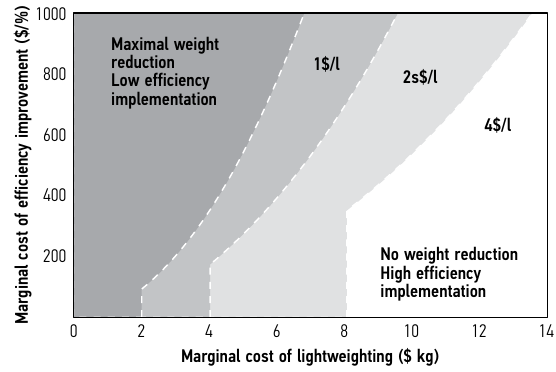
Fig. 12. Tolerance for high-cost technology implementation increases with increasing fuel cost for static marginal costs of technology implementation